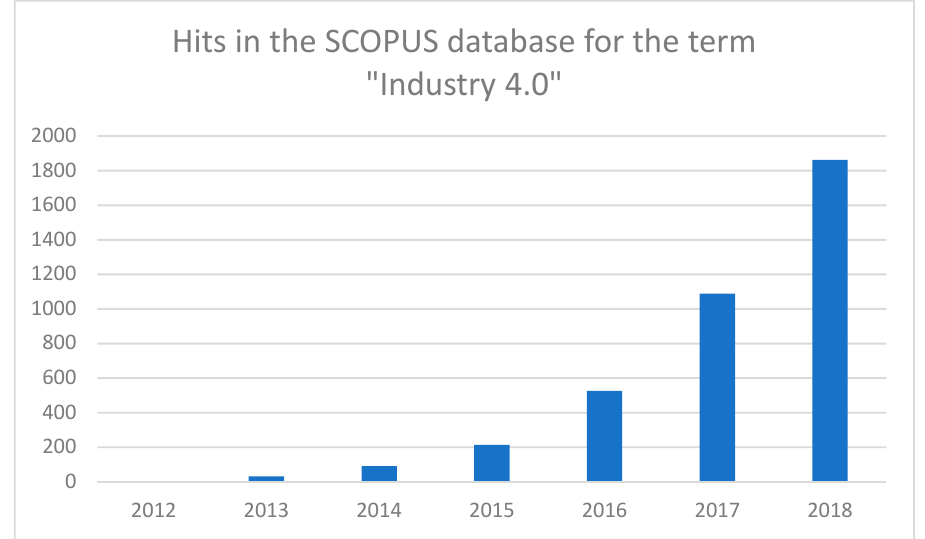
Figure 1. Hits in the SCOPUS database for the term “Industry 4.0” (Source: www.scopus.com; Retrieved 5 February 2019 and displayed using Microsoft Excel).